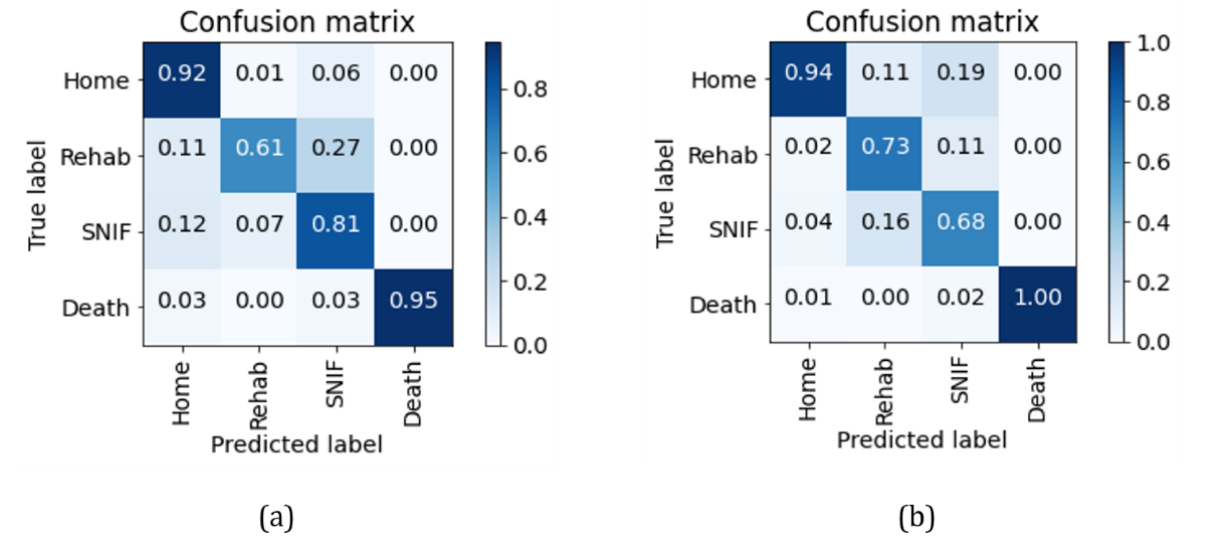
Figure 2. Confusion matrices for the best model evaluated in the hold-out test set normalized (A) by recall and (B) by precision. SNIF: skilled nursing inpatient facility.